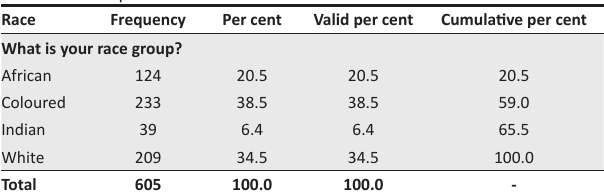
TABLE 2: Participants’